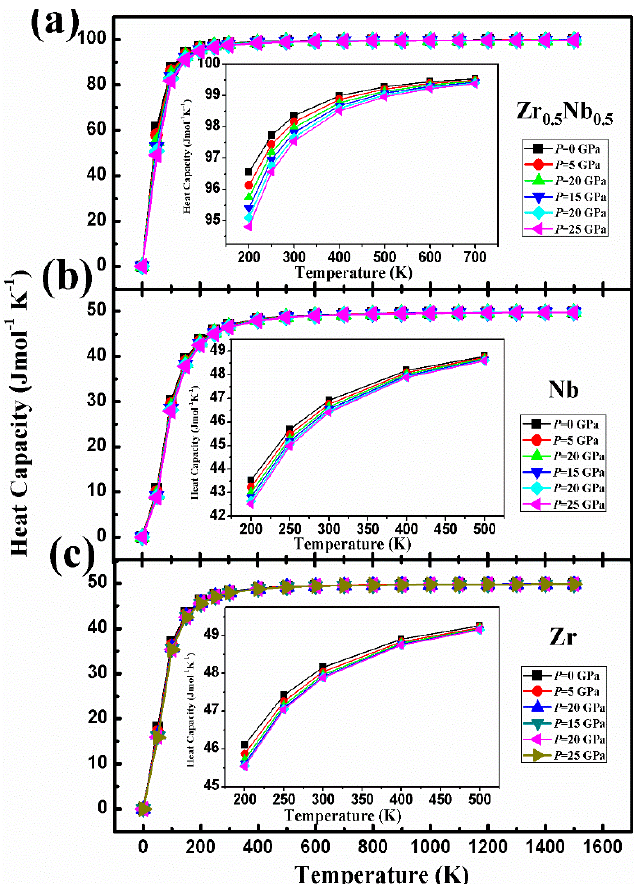
Figure 7. ( a ) Heat capacity ( C v ) of Zr 0.5 Nb 0.5 as a function of temperature at certain pressures up to 25 GPa, in comparison with those for ( b ) Nb and ( c ) hcp -Zr metals.